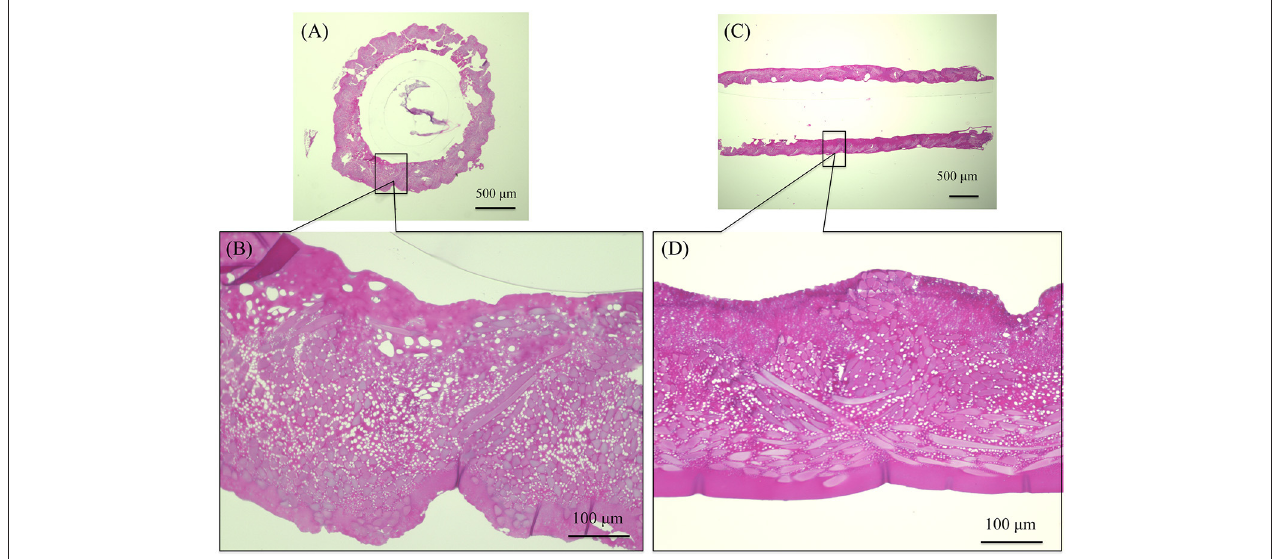
FIGURE 3 | Hematoxylin and eosin staining of elastin (EL)–silk fibroin (SF) graft before implantation: (A) histological cross-section image and (B) higher magnification of the EL–SF graft, (C) histological longitudinal-section image and (D) higher magnification of the EL–SF graft. The gaps among the SF fibers in the double-raschel knitted graft were filled with a lot of spongy EL.